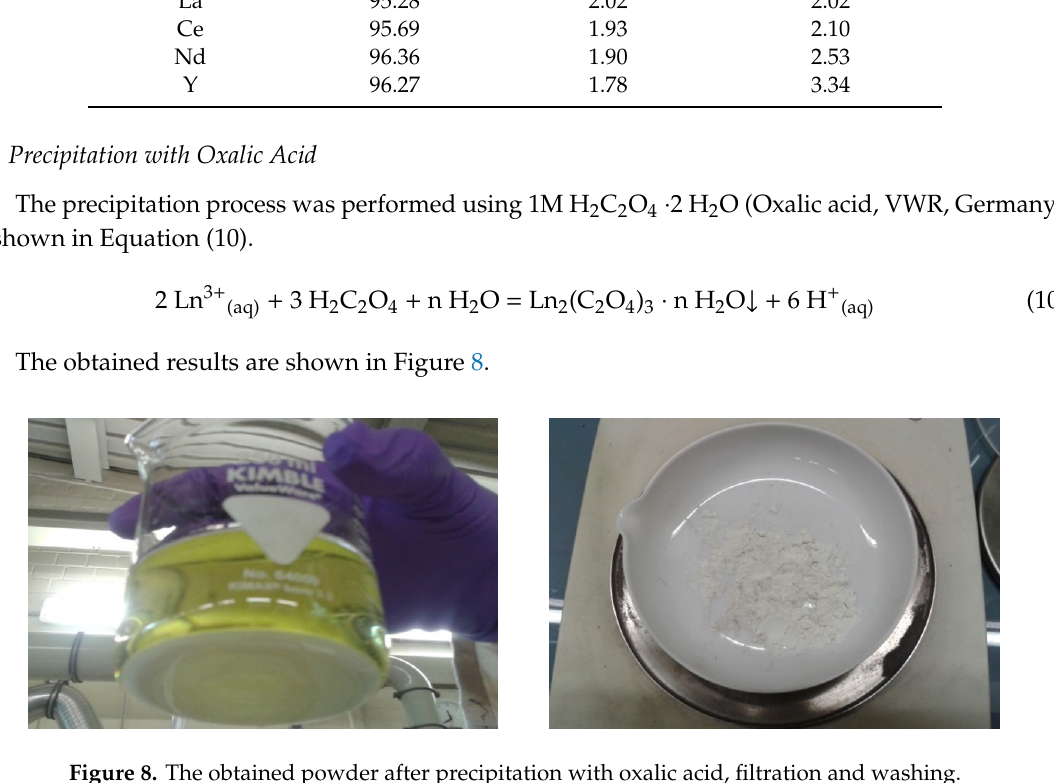
Table 7. Precipitation efficiency (%).